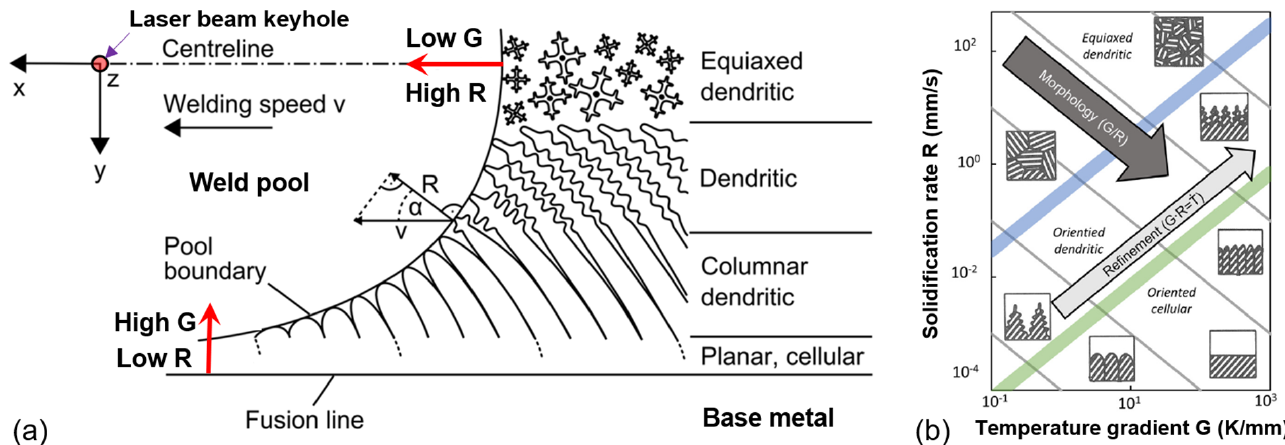
Figure 13. ( a ) Weld structure of aluminium alloys, modified from [167]. ( b ) Solidification mode map with influence of various factors adopted for Al alloys [185].